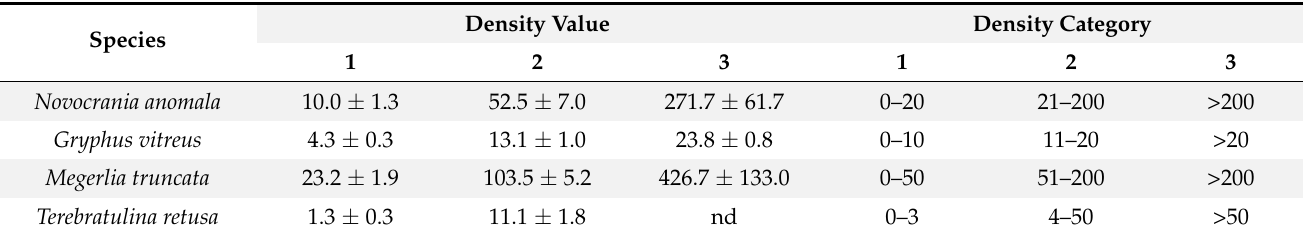
Table 3. Reference values of average density (n ◦ individuals m − 2 ± SE) and density category (min- max) for the four targeted brachiopod species extrapolated from the analysis of the photos for each aggregation